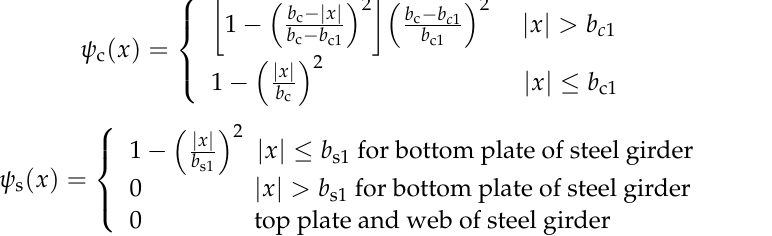
where y h is the y -directional coordinate of C s ; x h is the x -directional coordinate of C s ; w c0 and w s0 are the longitudinal displacements of O c and O s , respectively; u 0 is the transverse displacement of O c or O s ; v 0 is the vertical displacement of O c or O s ; ϕ is the torsion angle of the overall structure; f c and f s are the intensity functions of warping due to shear lag on the concrete slab and steel beam, respectively; and ψ c ( x ) and ψ s ( x ) are the functions of warping due to shear lag on the concrete slab and steel beam, respectively. The functions of warping on the concrete slab are calculated based on Equation (2). For the steel U-beam, there is no warpage due to shear lag in the upper flange and web; thus, ψ s ( x ) = 0. For the bottom flange of the steel beam, the shear lag needs to be considered and is calculated by Equation (3).